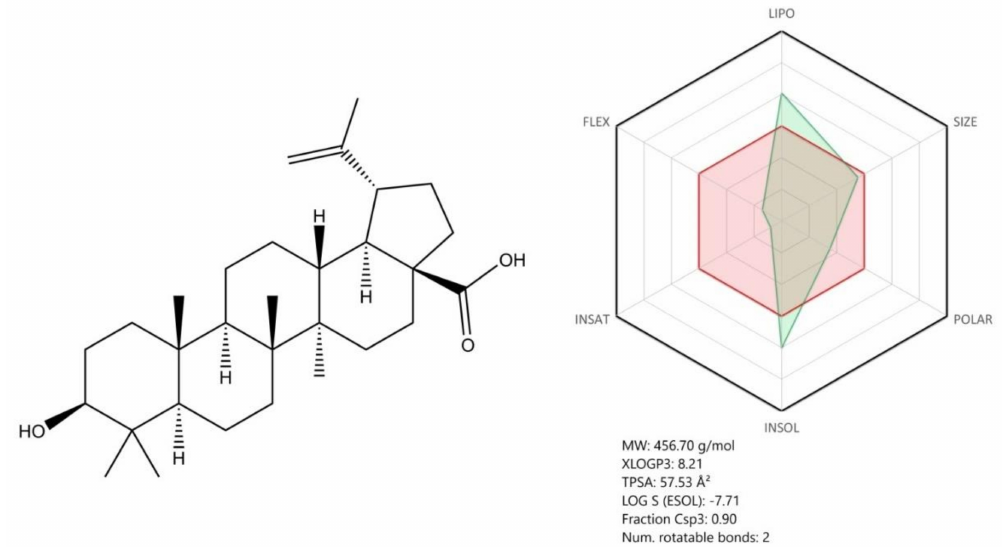
Figure 13. Chemical structure of betulinic acid ADME profile was achieved using the free web tool SwissADME; the red highlighted area represents the suitable physicochemical space for oral bioavailability covering value intervals for the following: LIPO (lipophility): − 0.7 < XLOGP3 < + 5.0, SIZE: 150 g / mol < MV < 500 g / mol, POLAR (polarity): 20Å 2 < TPSA < 130Å 2 , INSOLU (insolubility): 0 < Log S (ESOL) < 6, INSATU (insaturation): 0.25 < Fraction Csp3 < 1, FLEX (flexibility): 0 < Num. rotatable bonds < 9, whereas the overlapped green highlighted area shows the calculated ADME profile for the molecule